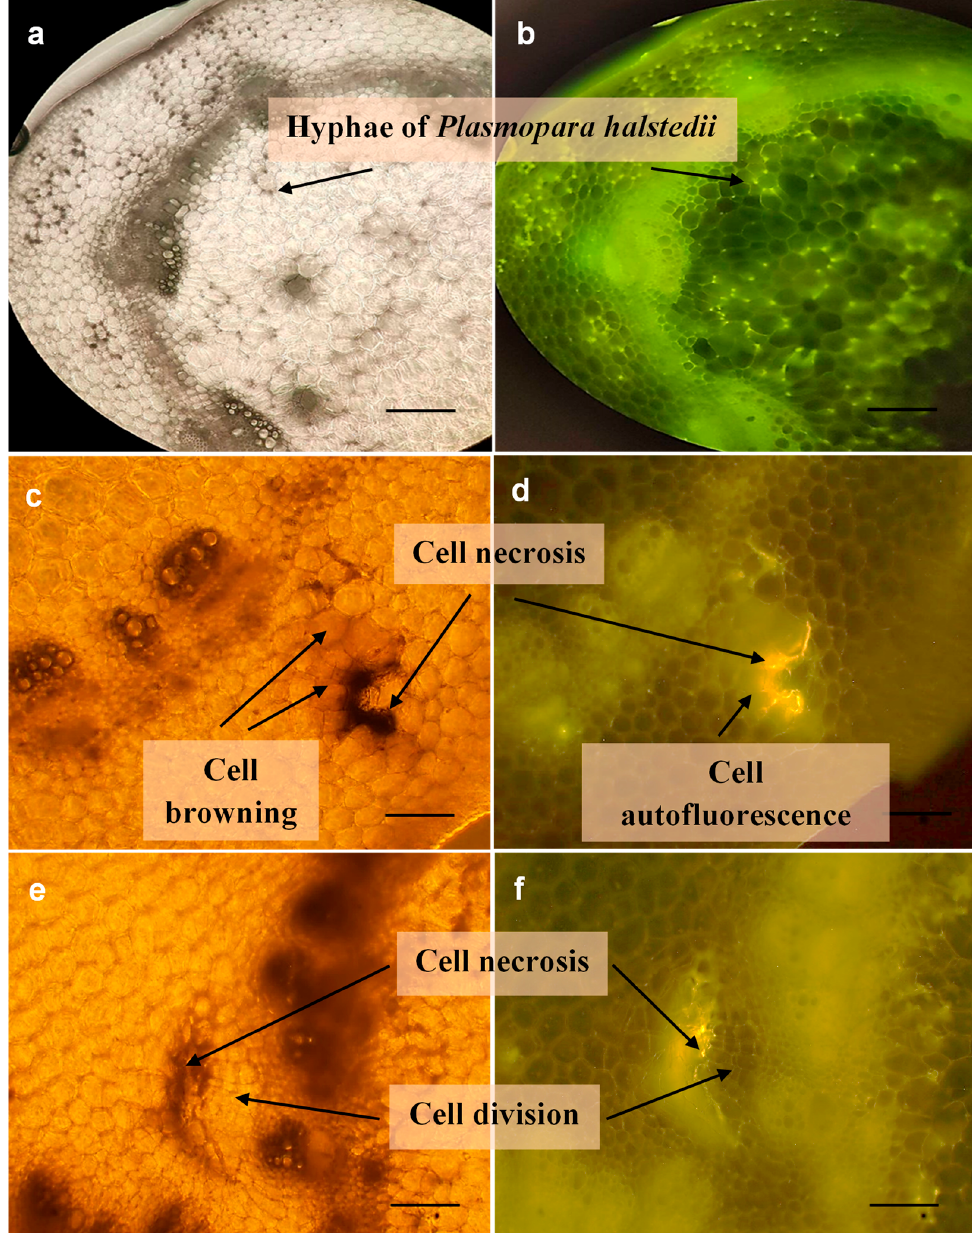
Figure 2. Light micrographs of mefenoxam-activated resistance responses in hypocotyl cross-sections of sunflower. Hyphae of Plasmopara halstedii invade cells of non-treated, inoculated susceptible plants (cv. Iregi szürke csíkos) without any host responses in normal ( a ) and in UV light ( b ) ( λ = 485 nm) at 21 dpi. Browning ( c ), autofluorescence (hypersensitive reaction) ( d ), and necrosis with intensive cell division ( e : normal light, f : UV light) of cortical parenchyma cells neighboring invaded cells as a host response to the pathogenic attack of mefenoxam-treated inoculated plants at 21 dpi. Scale bar = 100 µm .